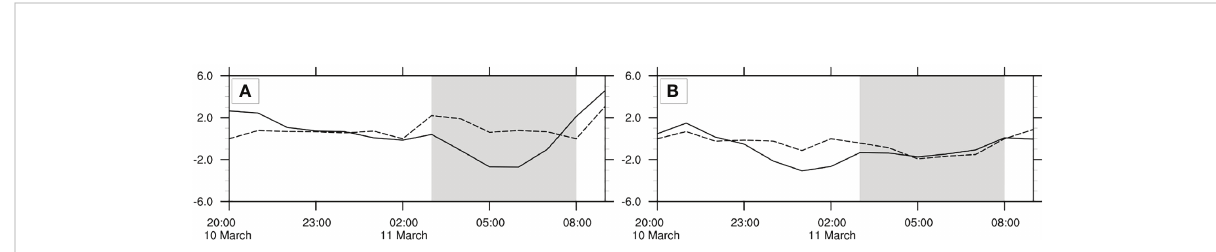
FIGURE 9 Temporal evolution of (A) latent heat fl ux (W·m -2 ) and (B) sensible heat fl ux (W·m -2 ) average value over the target area (marked by the black rectangular frame in Figure 7) by using the coupled (solid line) and uncoupled (dashed line)